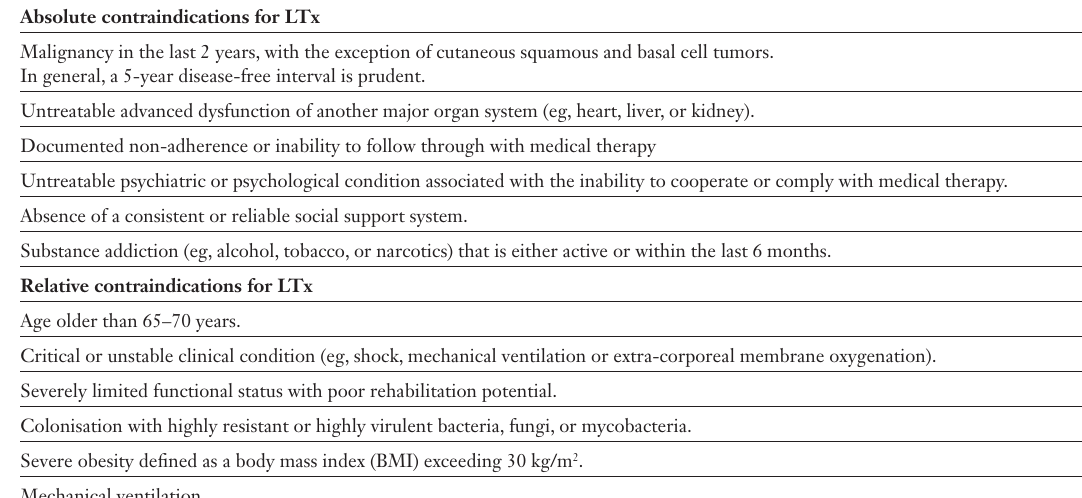
Contraindications for lTx.